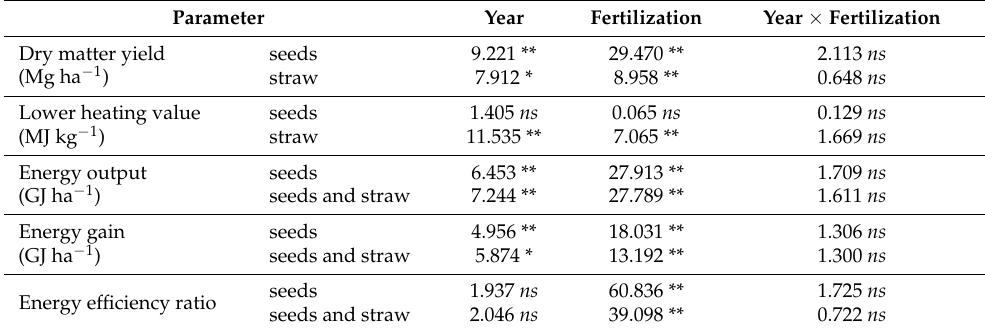
Table 4. F -test statistics in